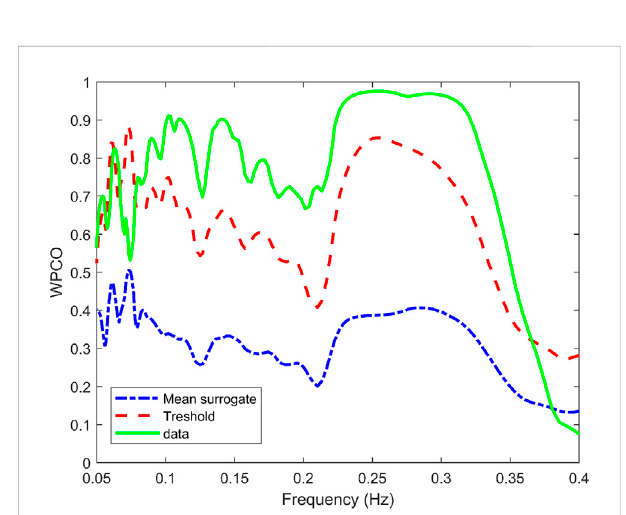
FIGURE 5 Wavelet phase coherence (WPCO) between the systolic blood pressure (SBP) and RR interval (solid green line) for a representative subject of the normotensive non-pregnant group. Moreover, WPCO between the SBP signals and the corresponding surrogates for the RR interval is shown. The mean (dash-dotted blue line) and mean±2 σ (dashed red line) is given for the